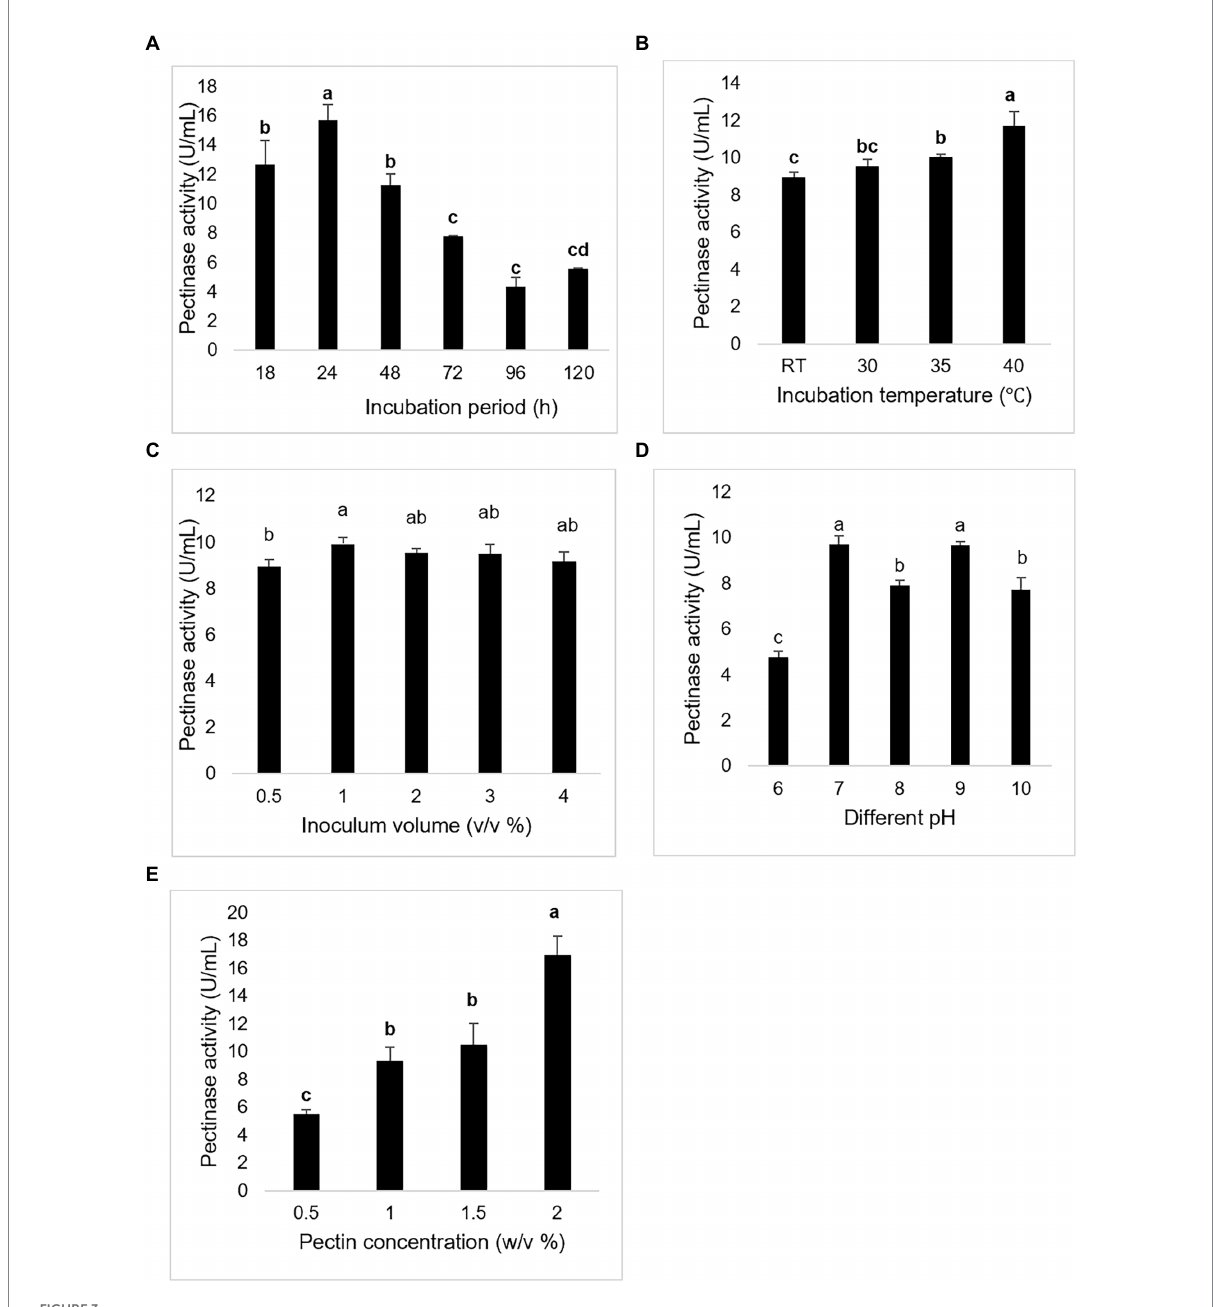
FIGURE 3 Pectinase activity at different (A) incubation period (h), (B) temperature ( ° C), (C) inoculum volume (% v/v), (D) pH, and (E) pectin concentration (% w/v). The bar represented the mean pectinase activity with the standard deviation error bar at different conditions. Lowercase alphabets indicate that the values are statistically significant at p ≤